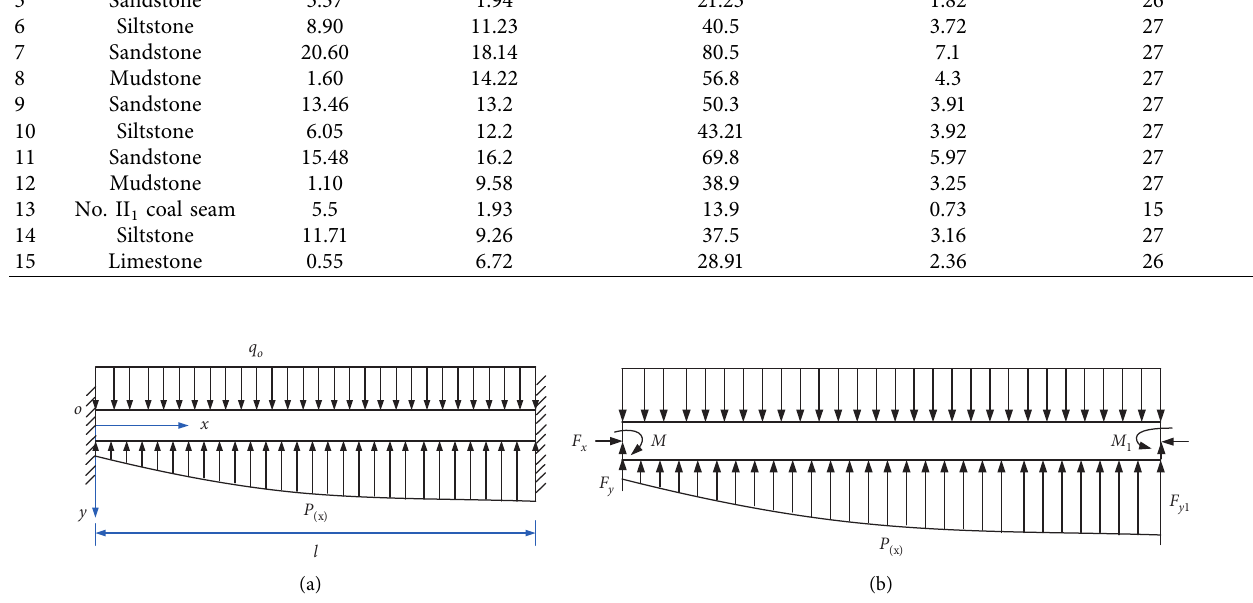
Figure 6: Mechanical model and stress model of the main roof. (a) Mechanical model of the main roof. (b) Stress analysis of the main roof.